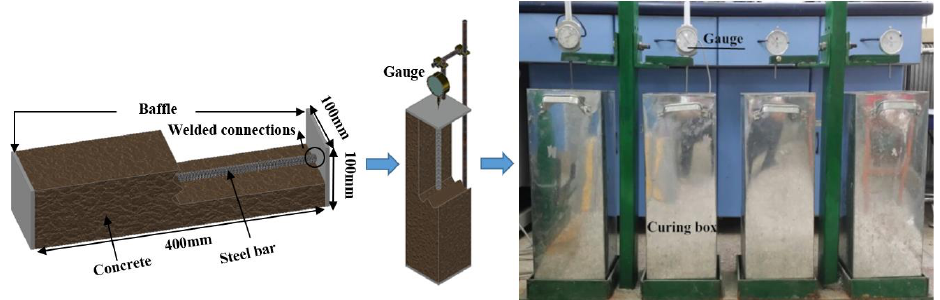
Figure 2. Process of self-stress value test.